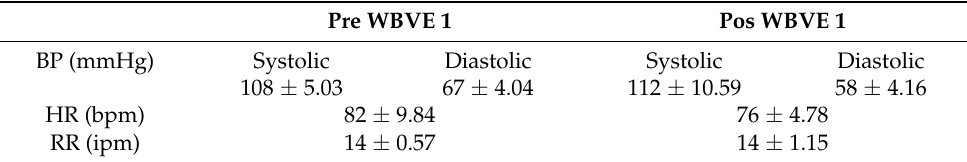
Table 1. Results of the first WBVE intervention on clinical parameters. Pre WBVE 1 Pos WBVE 1 BP (mmHg)